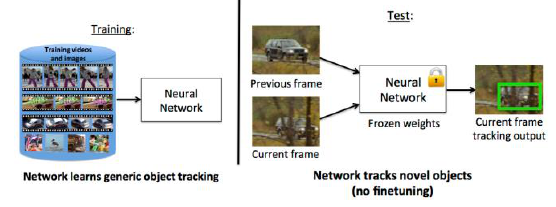
Figure 2. Scheme of the algorithm TLD